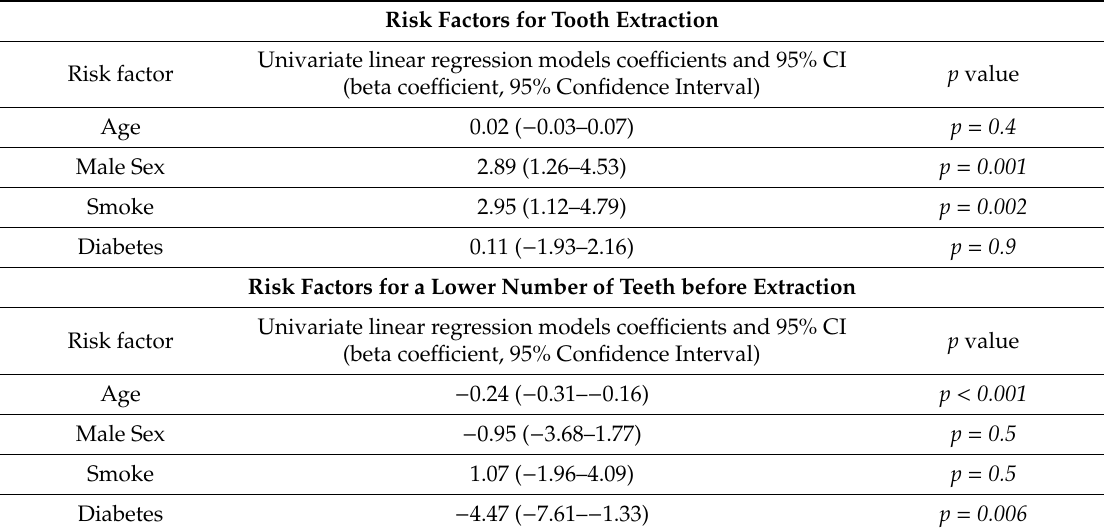
Table 3. Risk factors for tooth